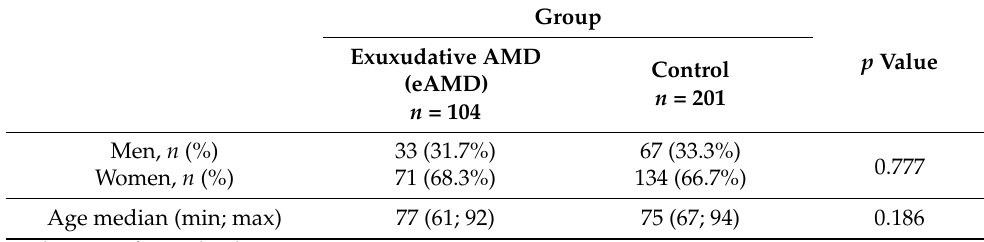
Table 1. Demographic data of the study